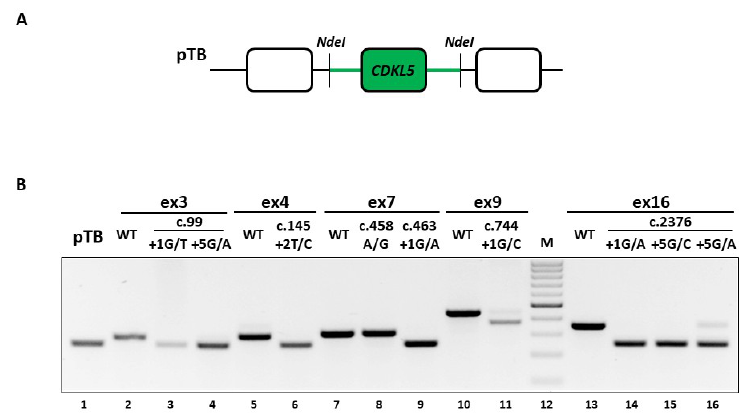
Figure 3. Splicing pattern analysis of CDKL5 variants. ( A ) Schematic representation of a CDKL5 minigene cloned into the pTB vector. Exonic and intronic sequences are represented by boxes and lines, respectively. Sequences of the pTB vector are depicted with empty boxes and black lines, while the CDKL5 minigene is shown in green. As indicated, the minigene was cloned within the NdeI restriction site of the pTB plasmid. ( B ) RT-PCR analysis of the CDKL5 minigene (wild-type or mutated) splicing pattern in HEK293T cells. Amplified products were separated on 2% agarose gel.